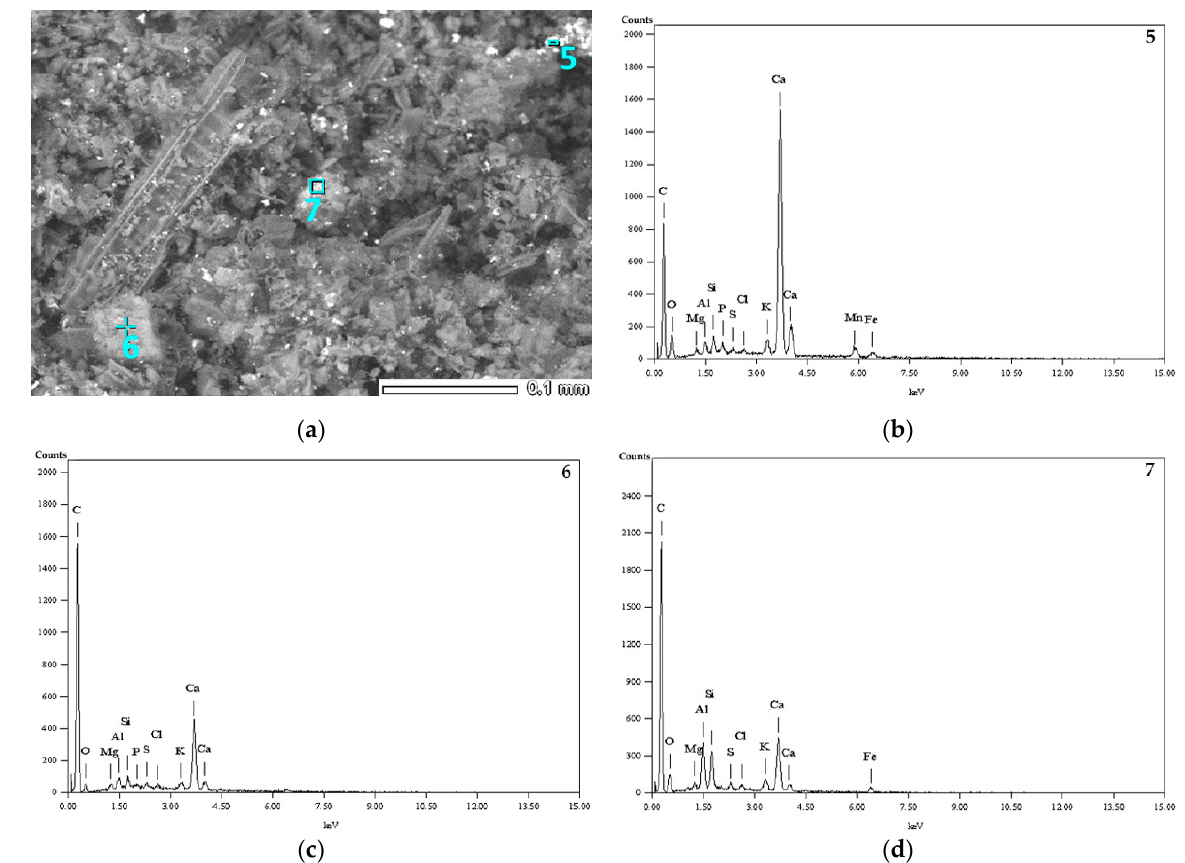
Figure 6. Dispersion energy spectra of X-rays (EDS) for individual nuggets (5, 6, 7) of activated carbon, ( a ) photo of analyzed sample of activated carbon; ( b – d ) spectra for points 5–7.